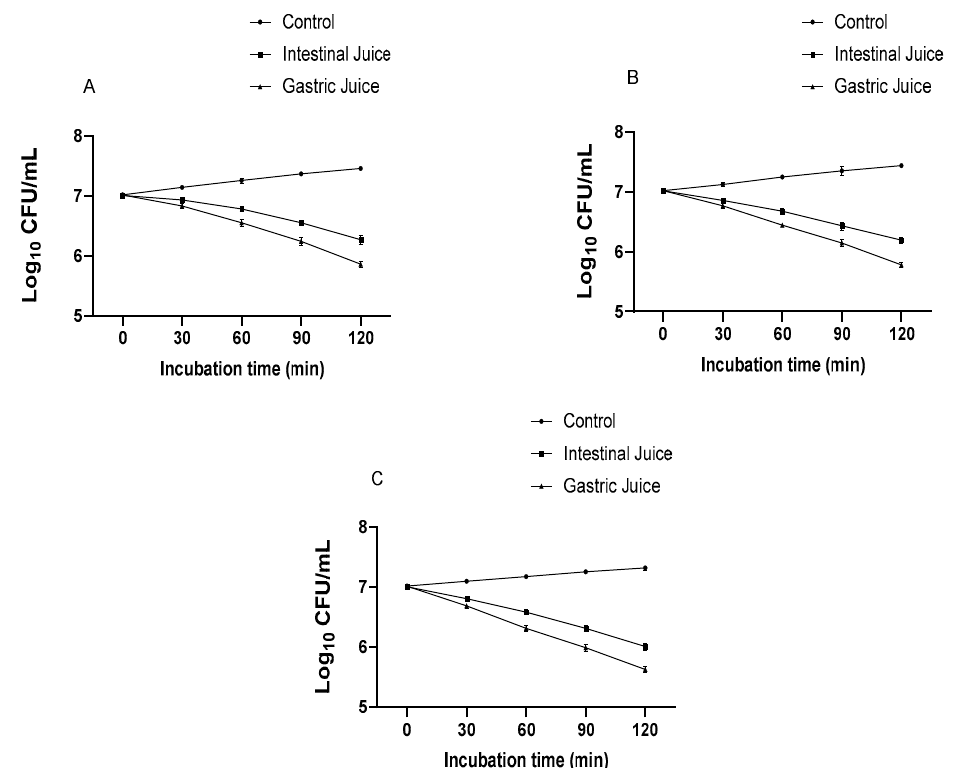
Figure 3. The survival rate of L. acidophilus AR1 ( A ), L. acidophilus AR2 ( B ), and L. fermentum AR3 ( C ) under simulated GIT conditions.